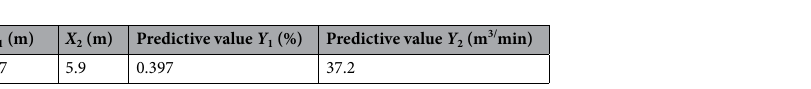
Table 6. Optimal results of response surface